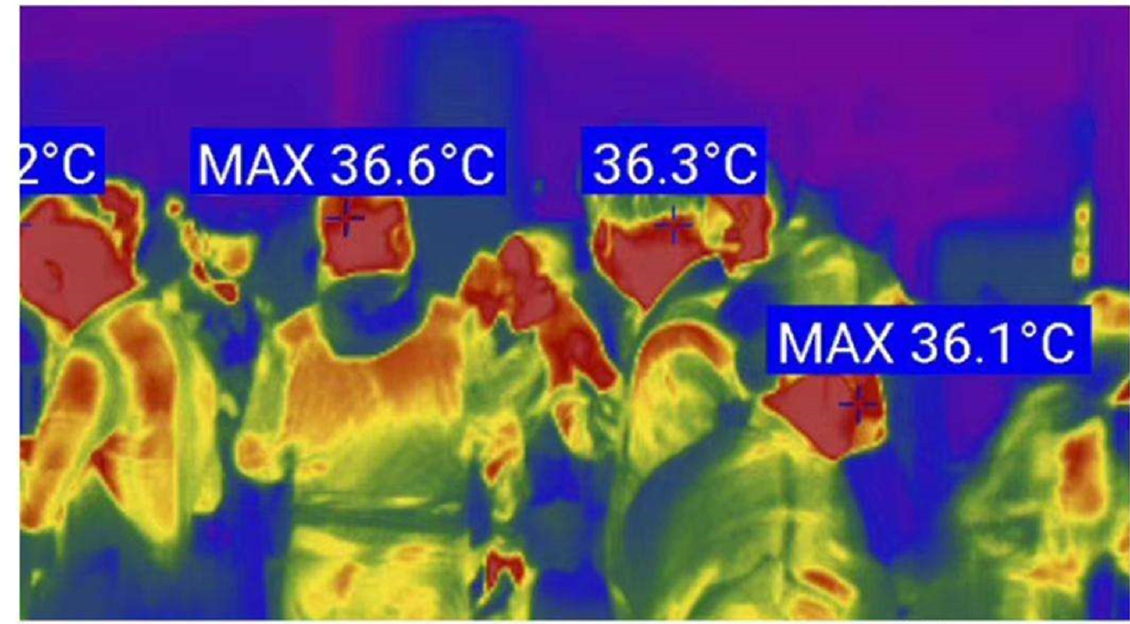
Figure 14. An example of a thermal temperature scan for group temperature measurement. [168].